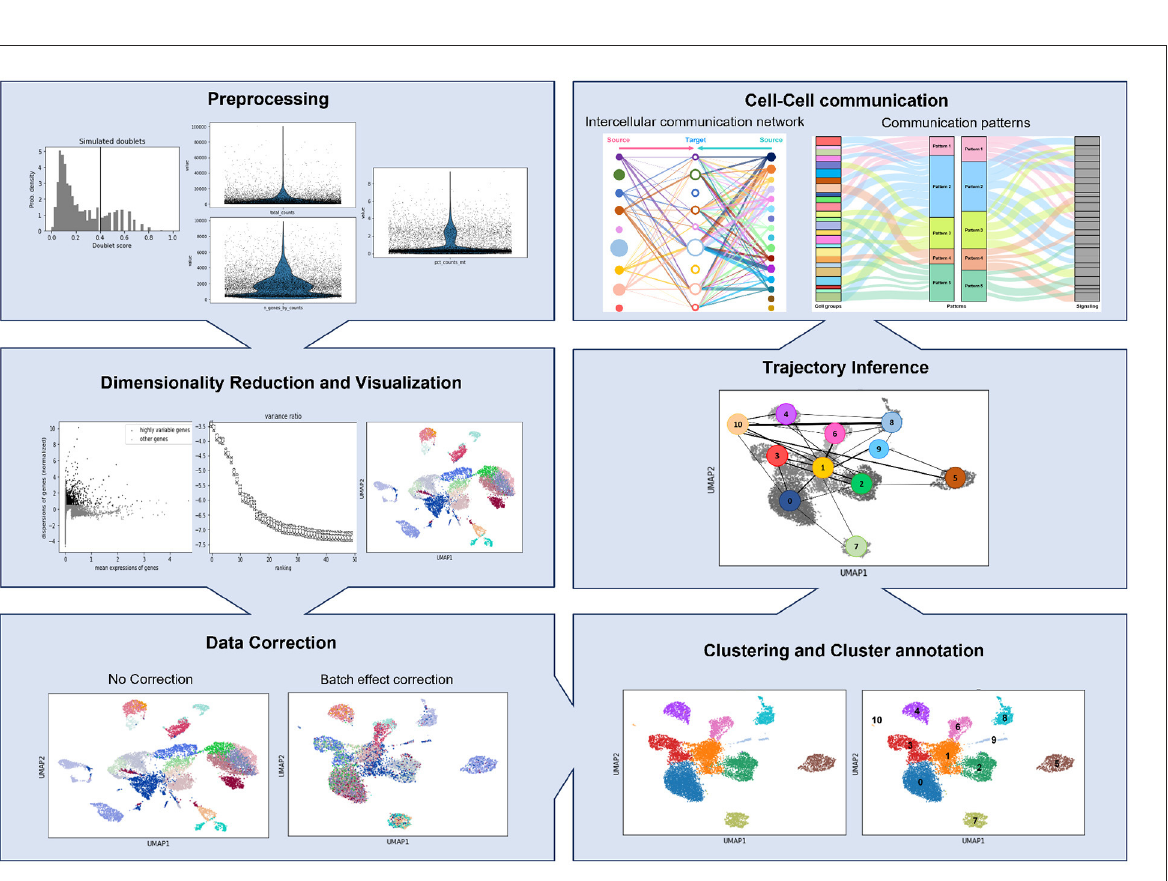
sequencing (scBS-seq) (Smallwood et al., 2014) and single- cell reduced representation bisulfite sequencing (scRRBS) ( Guo et al., 2013). However, due to the non-static characteristics